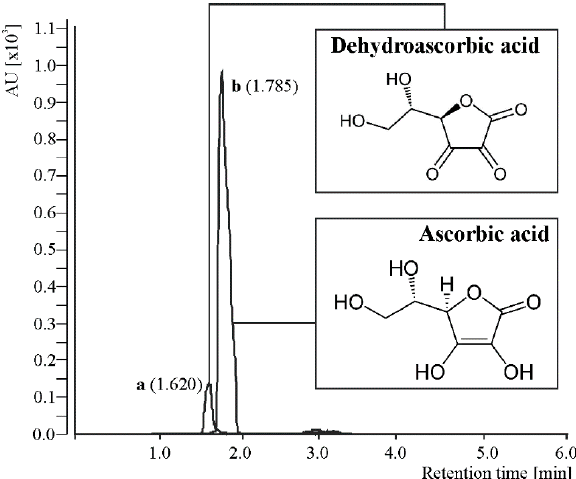
Figure 1. Representative overlap spectra of dehydroascorbic acid ( a ) and ascorbic acid ( b ) obtained by UHPLC-ESI-QqQ-MS / MS working in the multiple reaction monitoring